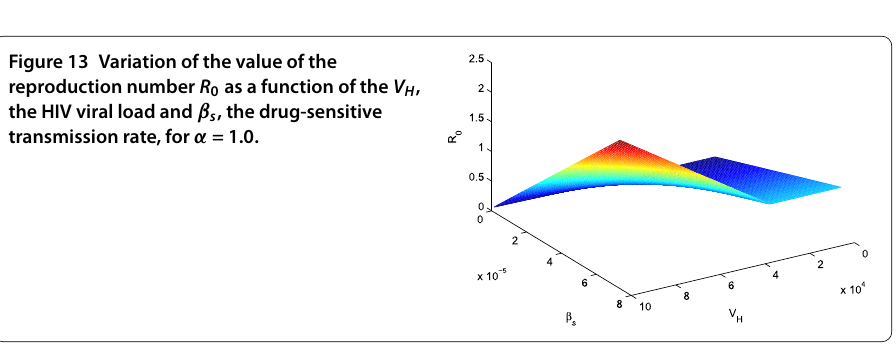
(preventive measures and treatment), and to treat HCV infection. The order of the frac- tional derivative seems to increase the severity of the disease, translated by higher HIV viral loads and infected hepatocytes. The results of the model are biologically reason-